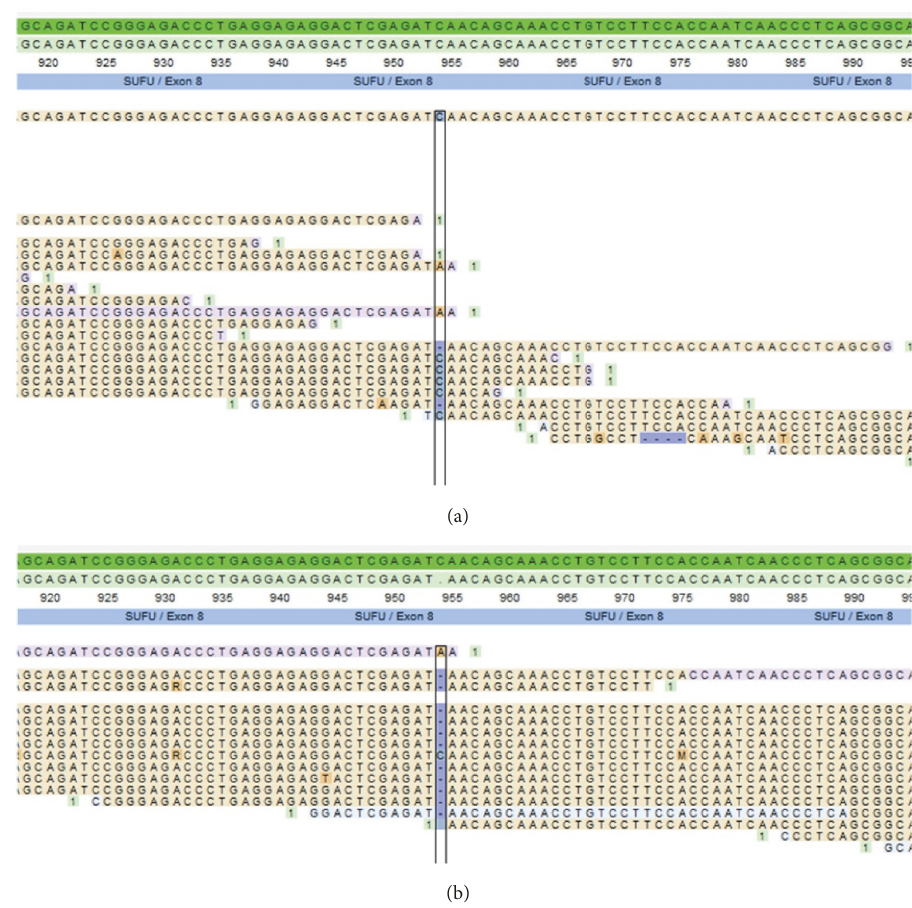
Figure 2: Reads of the meningioma tissue of case I and III. (a) Case I, showing the SUFU c.954delC variant but no LOH. (b) CaseIII, showing the SUFU c.954delC variant and LOH.